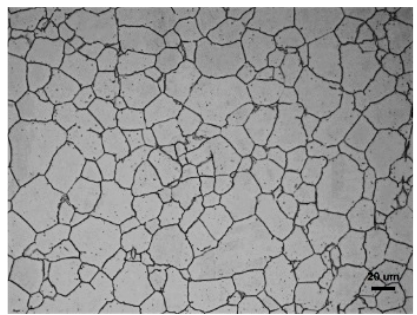
Figure 6. Microstructure of the 304SS base metal.